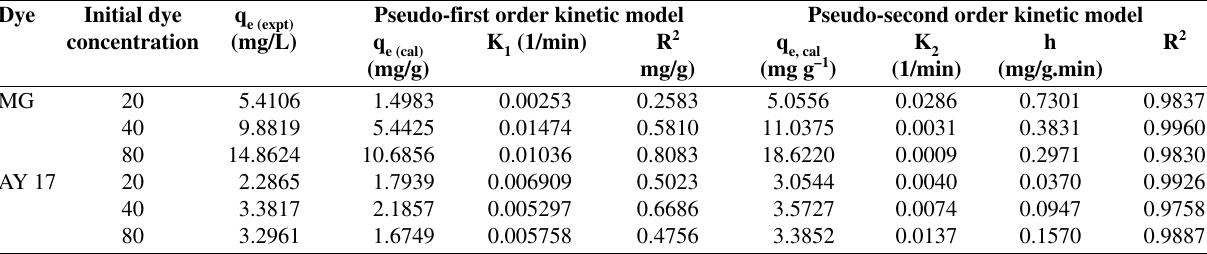
Table 1 . Adsorption capacities, kinetic model parameters and correlation coefficients based on pseudo-first and pseudo-second order kinetic mo- dels Dye Initial dye Pseudo-first order kinetic model Pseudo-second order kinetic